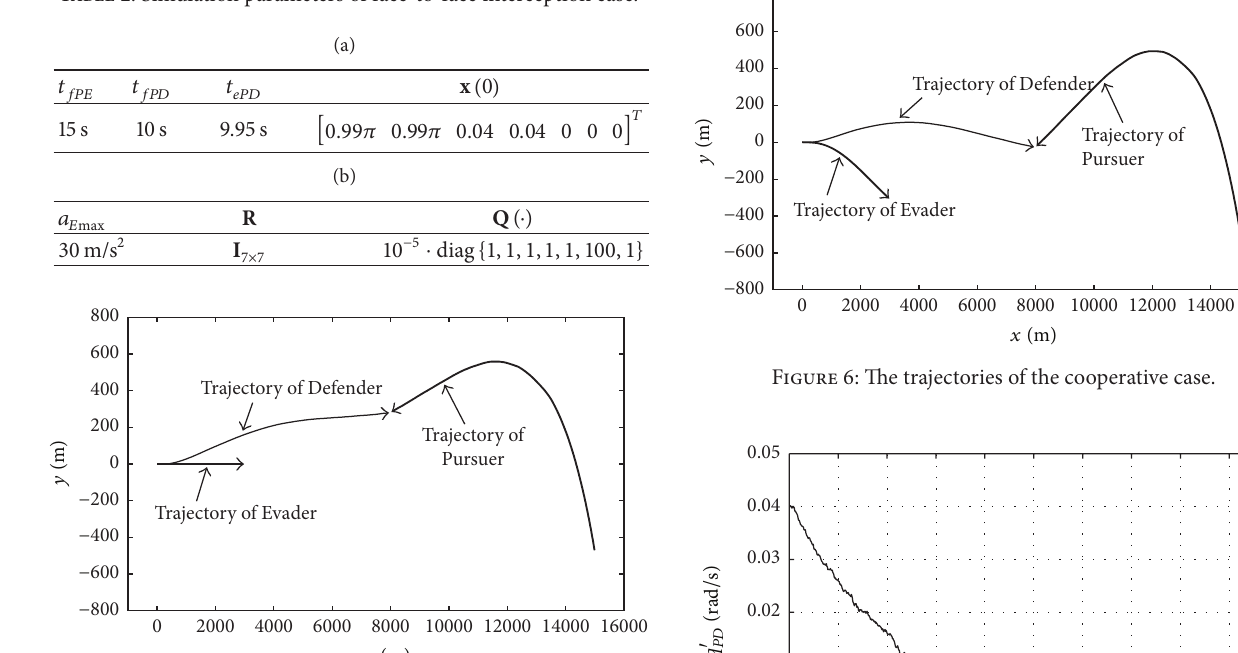
Table 2: Simulation parameters of face-to-face interception case.